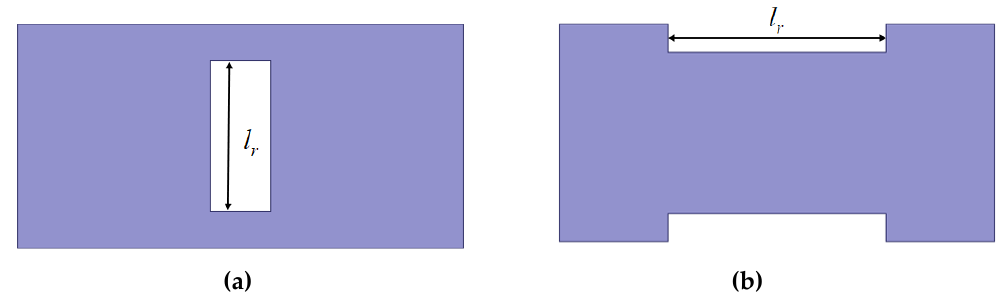
Figure 23. Optimization method on the ferrites applied in a DD coupler: ( a ) Primary core; ( b ) Secondary core.